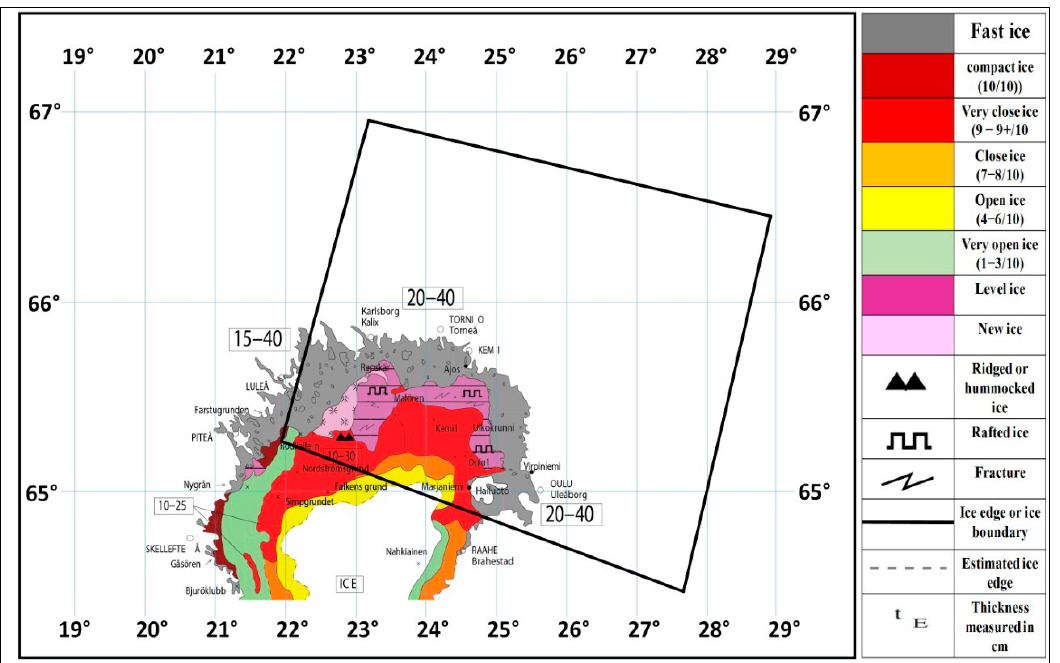
Figure 2. Ice chart of 7 February 2015 for the Bay of Bothnia [22]. The SAR images cover a 250 km swath at 5 m × 20 m spatial resolution. IW swath is marked with a square. Landfast ice is shown by the grey area . Reproduced with permission from ‘Finnish Ice Service (FIS)’, 2015.